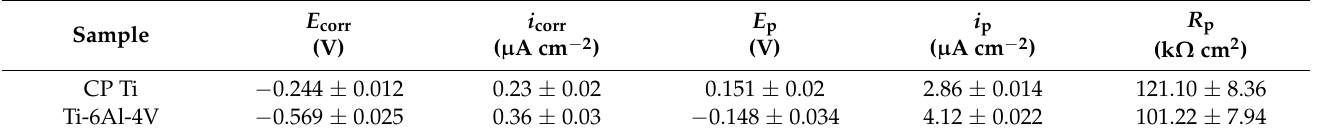
After potentiodynamic polarization measurements, the surface condition of CP Ti and Ti-6Al-4V samples was examined by SEM, while the elemental composition of the surface at individual positions was determined by EDS analysis. The obtained results are shown in Figure 4 and Table